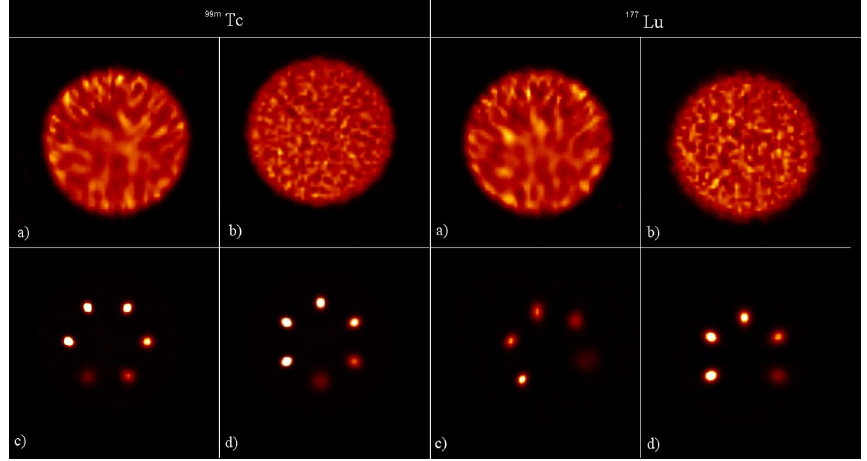
Fig. 6 SPECT reconstructed transverse slices of the Jaszczak phantom without spheres a experimental and b simulated, with spheres c experimental and d simulated. On the left 99 m Tc, on the right 177